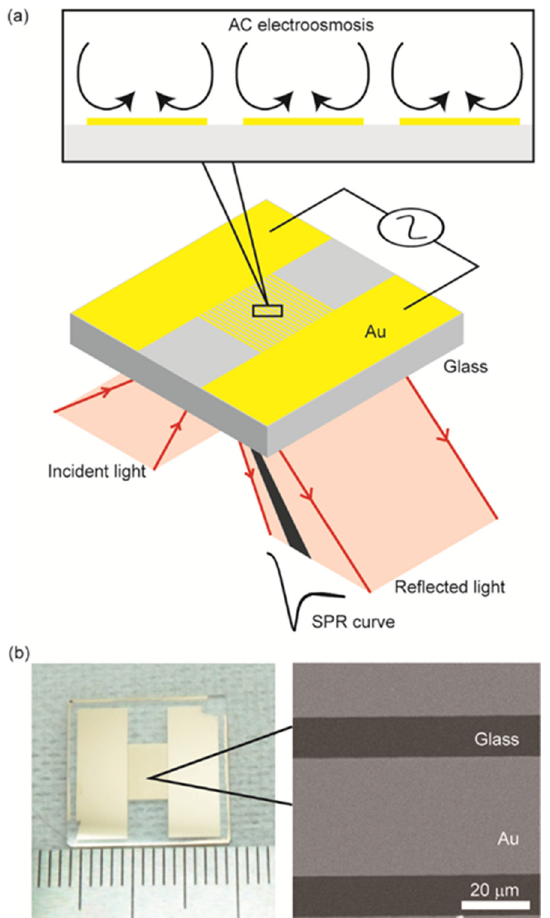
Figure 1. SPR sensing with a comb-shape Au chip for ACEO: ( a ) Schematic of SPR sensing with the Kretschmann configuration; the inset shows the side view of the flow induced by ACEO above the microelectrodes; ( b ) Sensor chip of Au comb-shape microelectrodes.